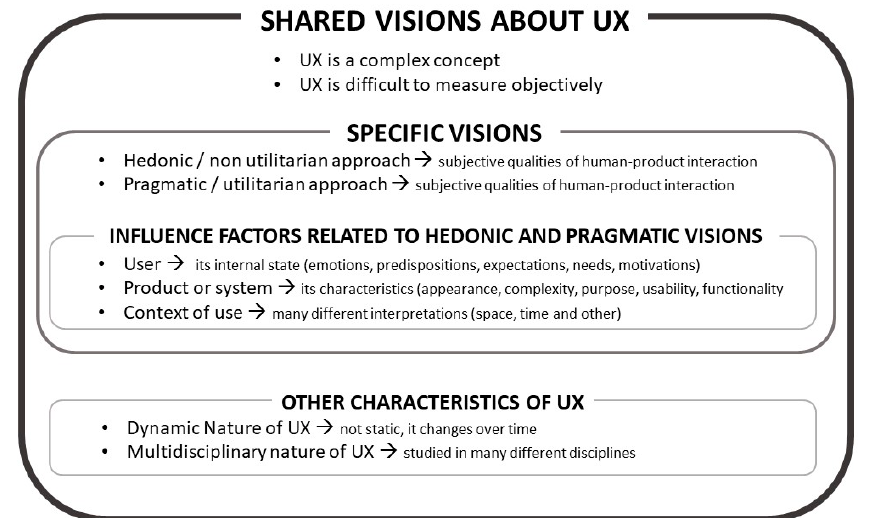
Figure 1. Graphical representation of the main visions of UX, and the influence factors related to the UX concept.